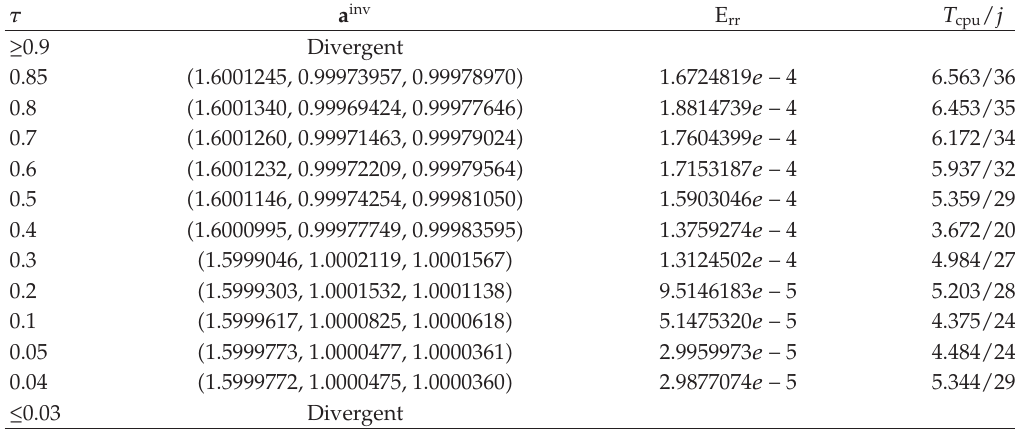
Table 5: Influence of numerical di ff erential step on the algorithm with μ (cid:8) 0 . 1.